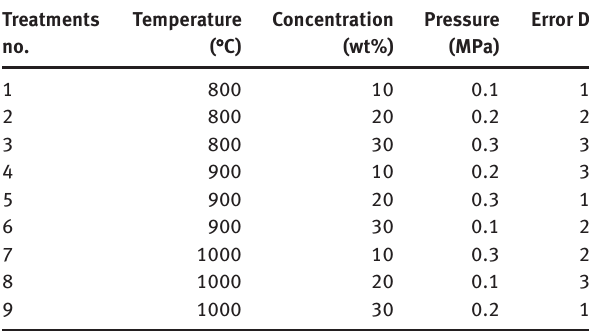
Table 2: The L9(3 4 ) orthogonal test with four factors and three